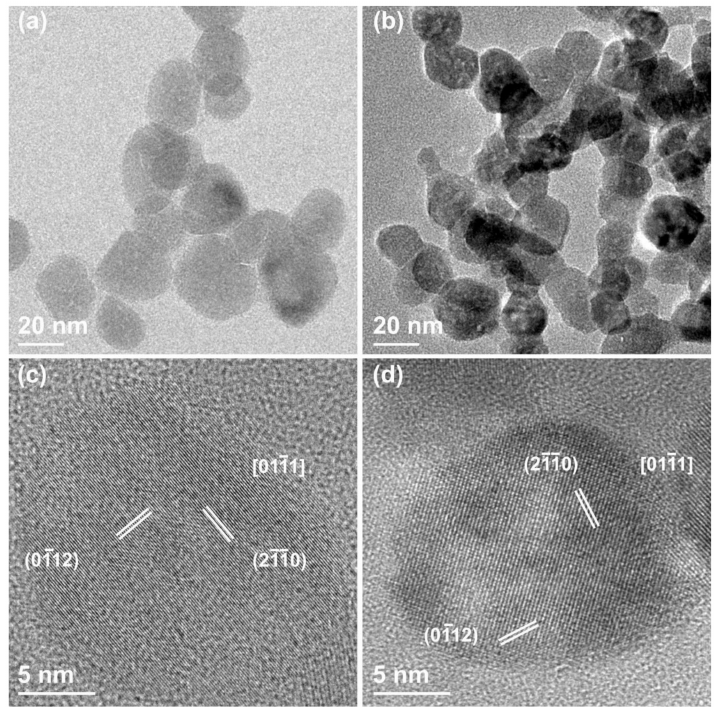
Figure 4. ( a , b ) CTEM and ( c , d ) HRTEM images of ( a , c ) pristine ZnO-mw NCs and ( b , d ) functionalized ZnO-mw-NH 2 , both obtained via microwave-assisted synthesis.